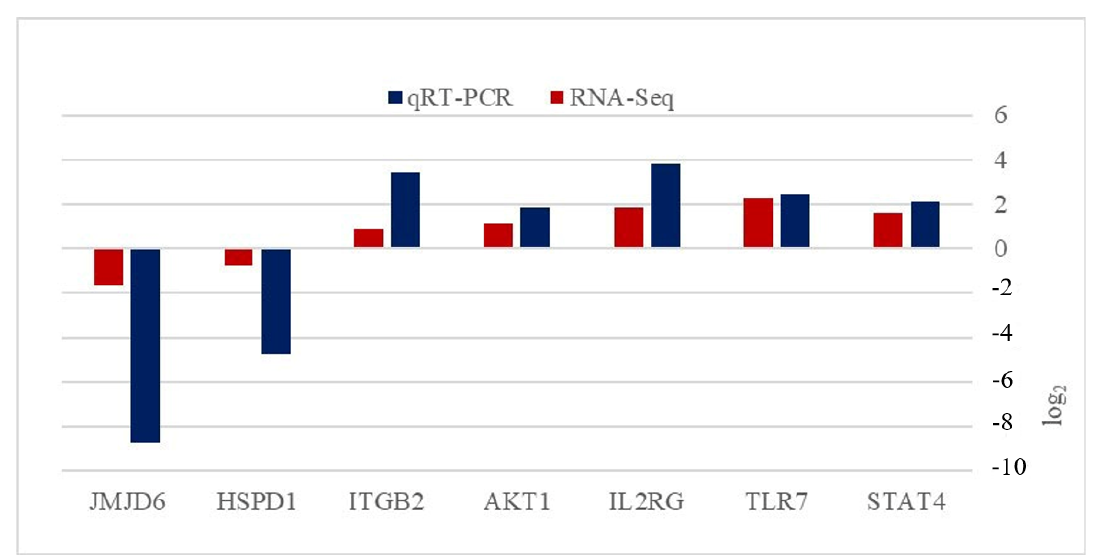
Figure 3. Fold-expression changes measured with RNA-Seq and real-time RT-PCR.